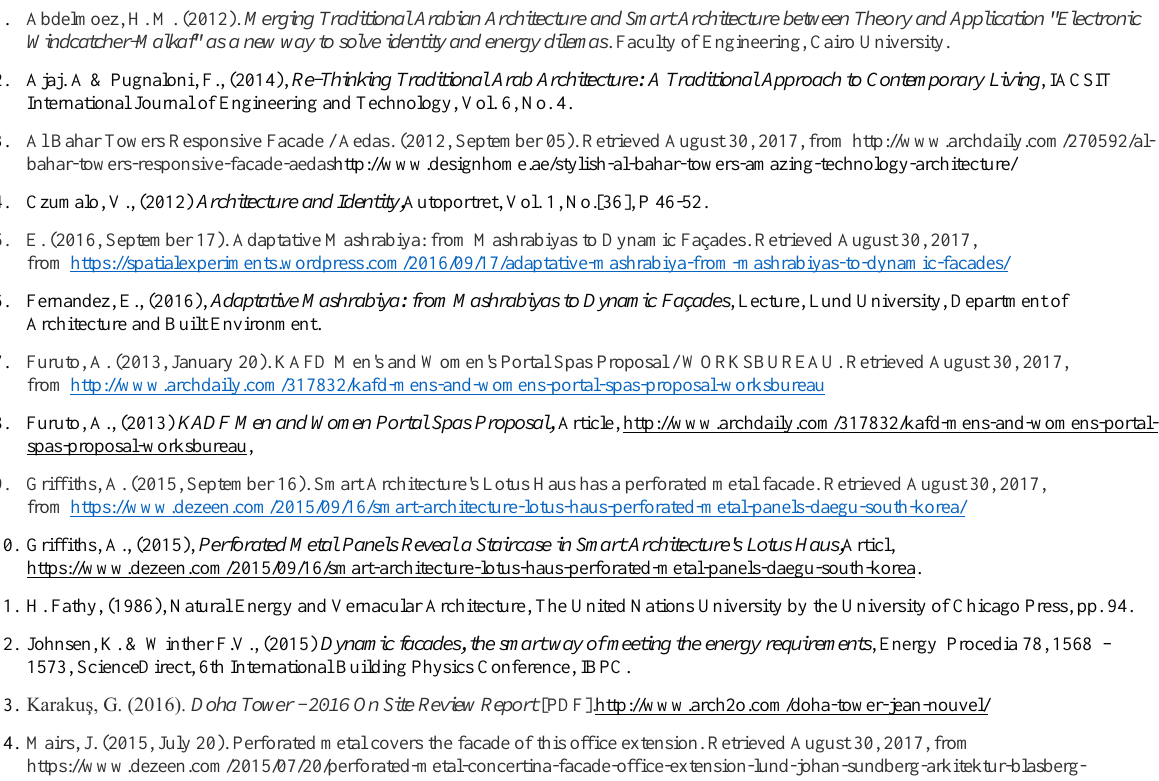
Fig 10(e) The cozy interior generated from the screening